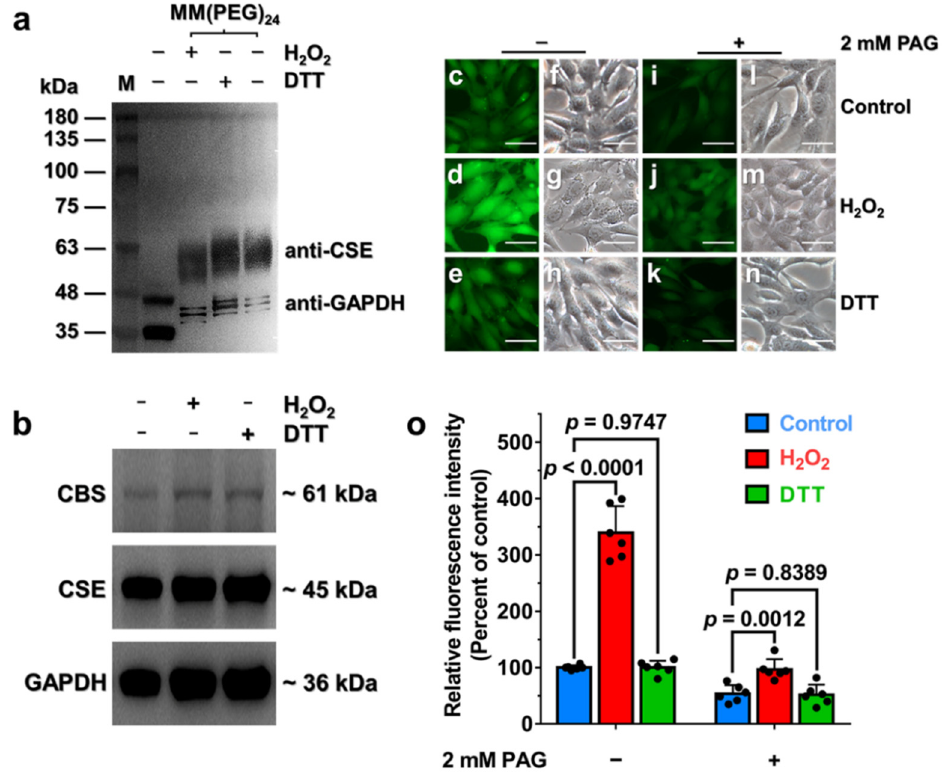
Figure 4. Increasing activity of CSE in its oxidized state enhances the H 2 S signaling in live HA- VSMCs. ( a ) Cells were exposed to 0.4 mM H 2 O 2 or 0.4 mM DTT for 30 min, followed by washing three times with ice-cold PBS buffer and were treated with 10% ( v / v ) trichloroacetic acid immediately at 4 °C for 30 min before being alkylated with 20 mM MM(PEG) 24 . The samples were resolved on SDS-PAGE and immunoblotted for CSE. ( b ) Cells were exposed to 0.4 mM DTT or 0.4 mM H 2 O 2 for 30 min. The cell lysates were resolved on SDS-PAGE and immunoblotted for CBS and CSE. ( c ) Untreated cells imaged as described in methods and were used as a control group. ( d ), Cells were incubated with 0.4 mM H 2 O 2 for 30 min at 37 °C and then imaged. ( e ) Cells were incubated with 0.4 mM DTT for 30 min at 37 °C and then imaged. ( f – h ) Brightfield images corresponding to ( c – e ). (Scale bar, 250 µm). ( i – k ) Cells were preincubated with 2 mM PAG for 12 h to inhibit CSE activity. Subsequently, the cells were incubated with PBS ( i ), 0.4 mM H 2 O 2 ( j ) or 0.4 mM DTT ( k ) for 30 min, washed and then imaged. ( l – n ) Brightfield images corresponding to ( i – k ) (Scale bar, 250 µm). ( o ) Quantification of the fluorescence microscope images of H 2 S signaling in HA-VSMCs, with data from ( c – e , i – k ) for comparison. The graph represents the relative fluorescence intensity compared with the relative fluorescence intensity of untreated cells ( c ) and shows the means ± SD ( n = 6). An unpaired two-tailed Student’s t test was used to determine the significance of differences between the two group means.